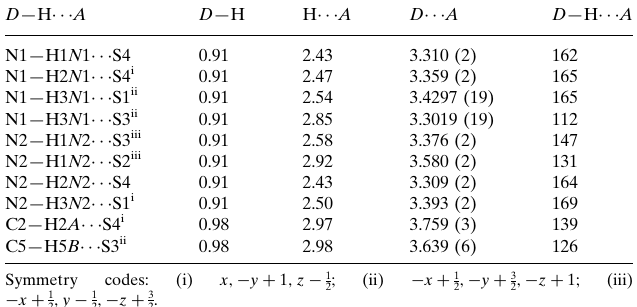
Hydrogen-bond geometry (A˚ , (cid:3)